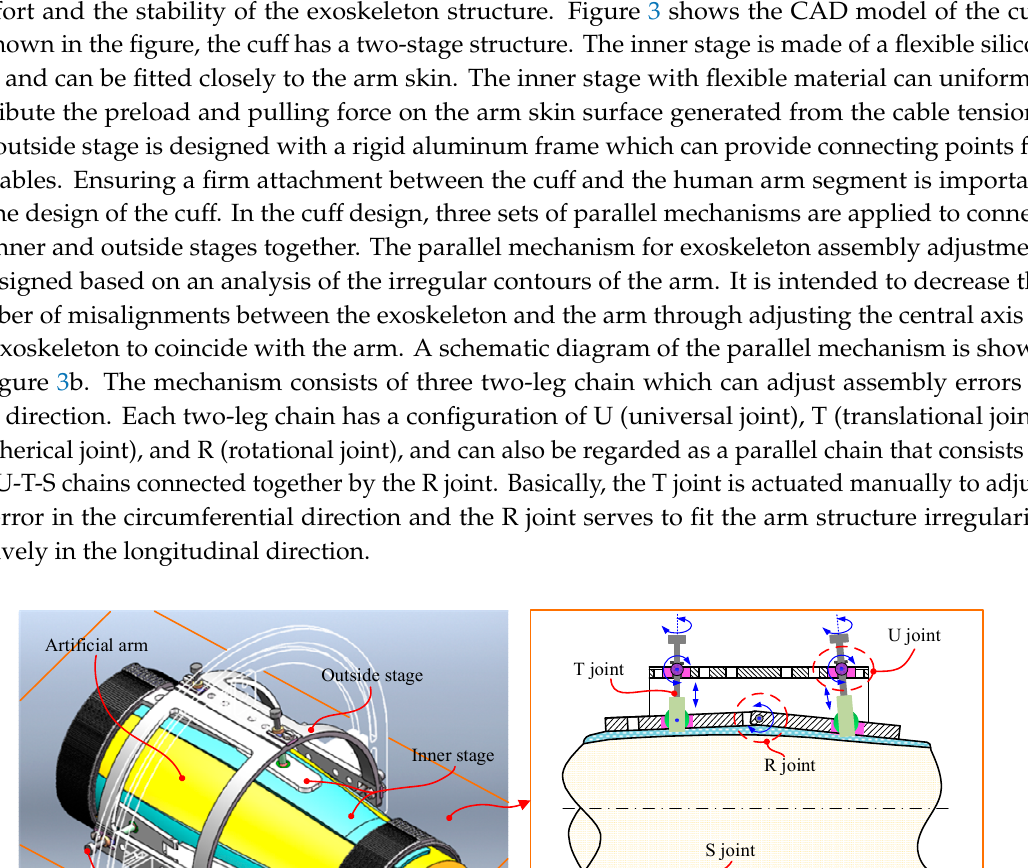
Figure 2. Schematic diagram of ( a ) the shoulder and ( b ) the elbow modules. In the diagram, local frames, (cid:4668)𝑂 (cid:2868) (cid:4669) , (cid:4668)𝑂 (cid:2869) (cid:4669) , and (cid:4668)𝑂 (cid:2870) (cid:4669) are located on the center of the shoulder joint, the center of the elbow joint, and the attachment point between the forearm cuff and human forearm, respectively; the global frame (cid:4668)𝑂 (cid:3008) (cid:4669) is located at the center point of base cuff.